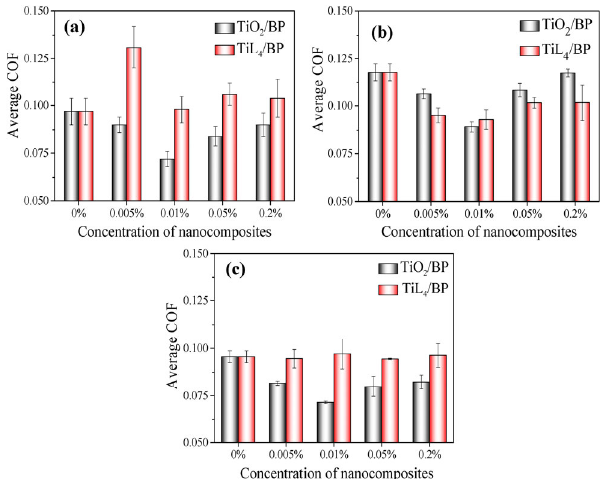
Fig. 4 Average COF of steel/steel contact lubricated by PAO6 containing or without BP nanocomposites under different loads: (a) 8 N, (b) 20 N, and (c) 30